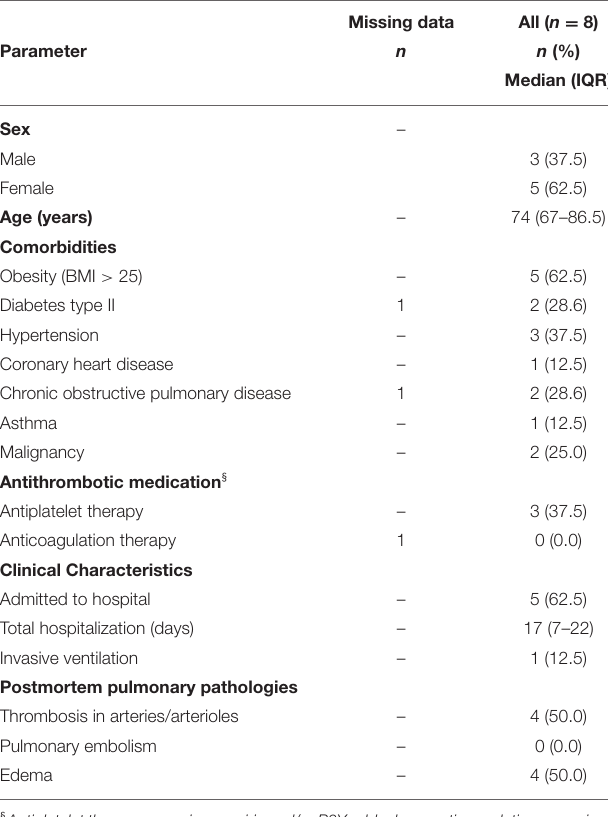
TABLE 1 | Patient demographics (postmortem lung